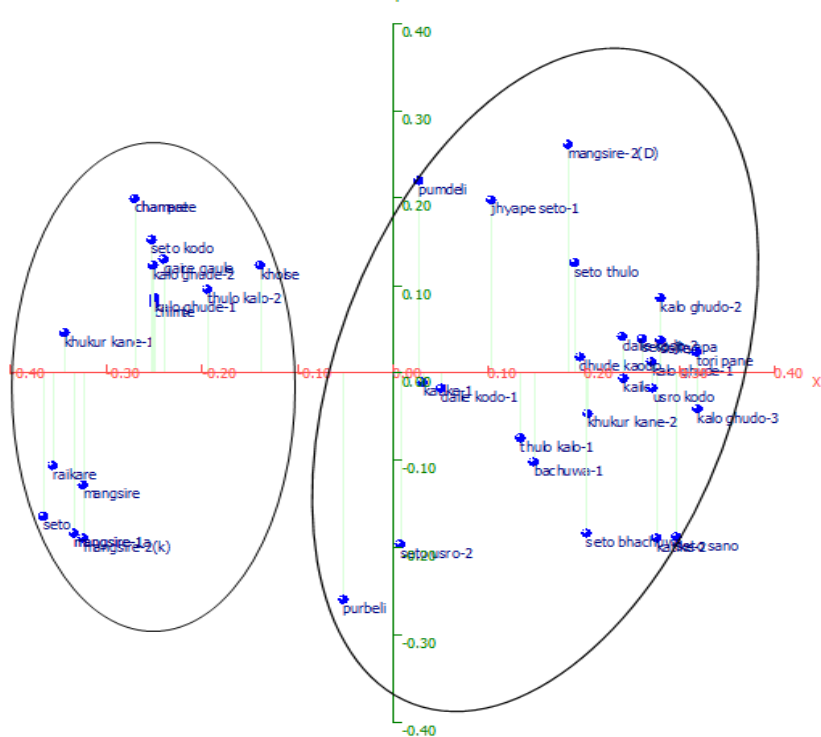
Figure 7. Scatter plot of 40 finger millet landraces using 5 SSR